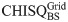
Parameter recovery for the LCA model with 1200 observations (300 in each of the four difficulty conditions); the true value on the abscissa and estimated value on the ordinate.The same parameters as in Fig 3 are shown. The method used to produce these estimates is the averaged bootstrap approach (CHISQBSGrid, see Methods for details).